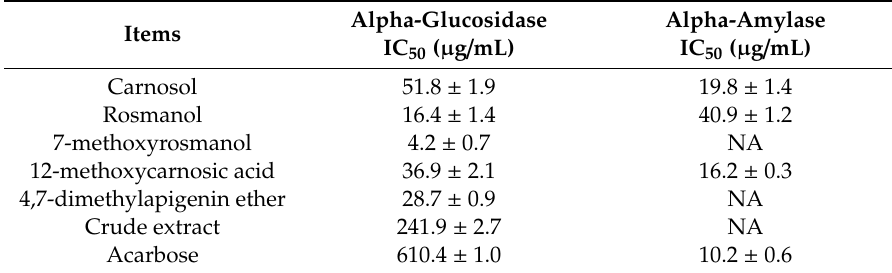
Table 1. Inhibitory activities of S. aurita constituents on alpha-glucosidase and